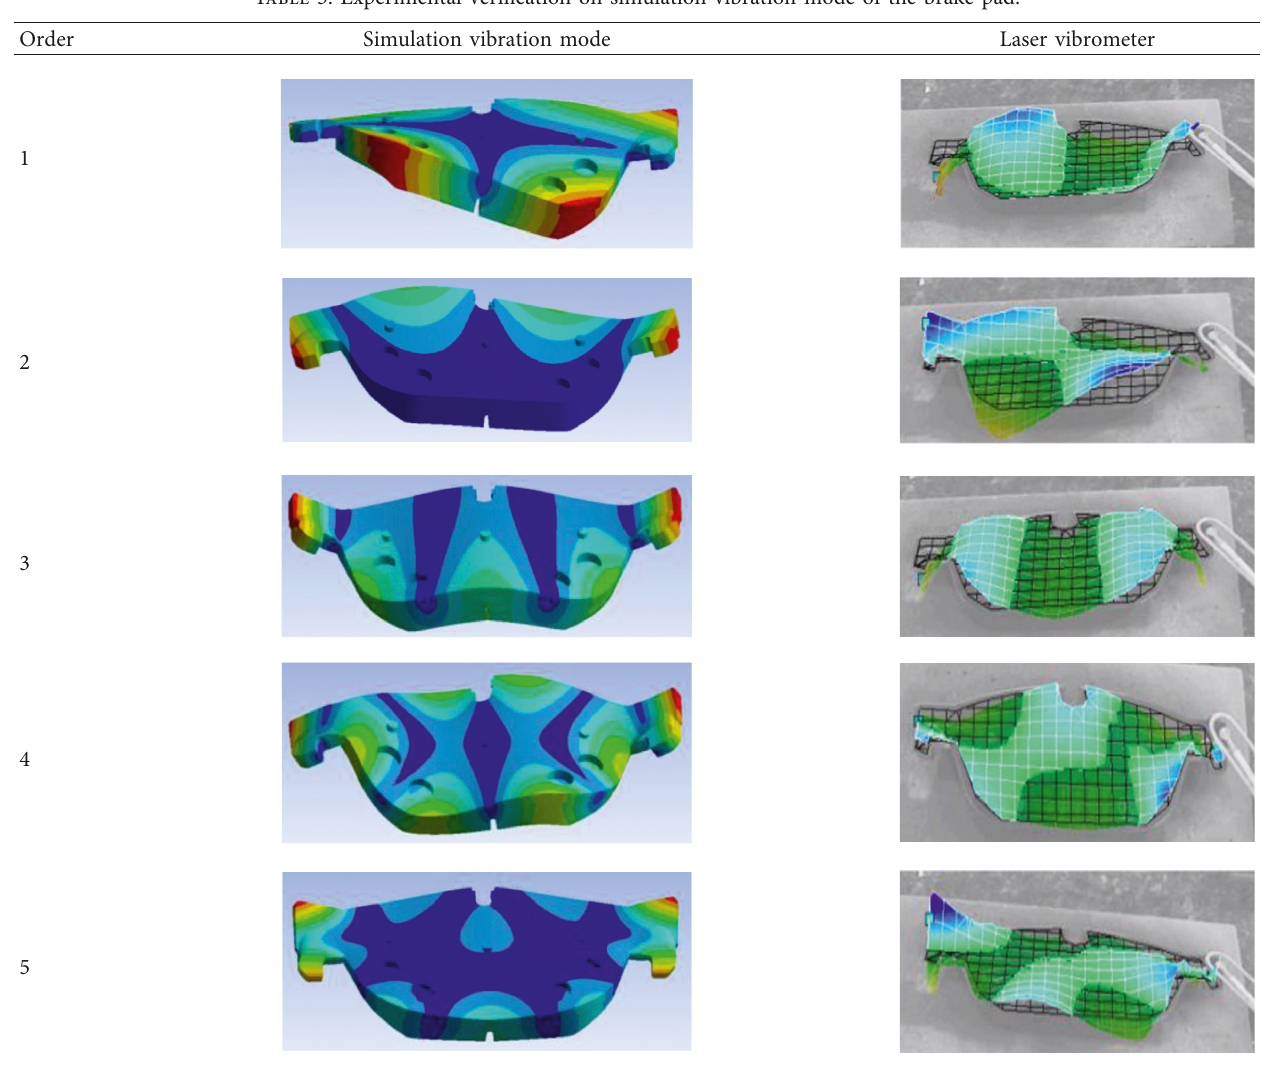
Table 5: Experimental verification on simulation vibration mode of the brake